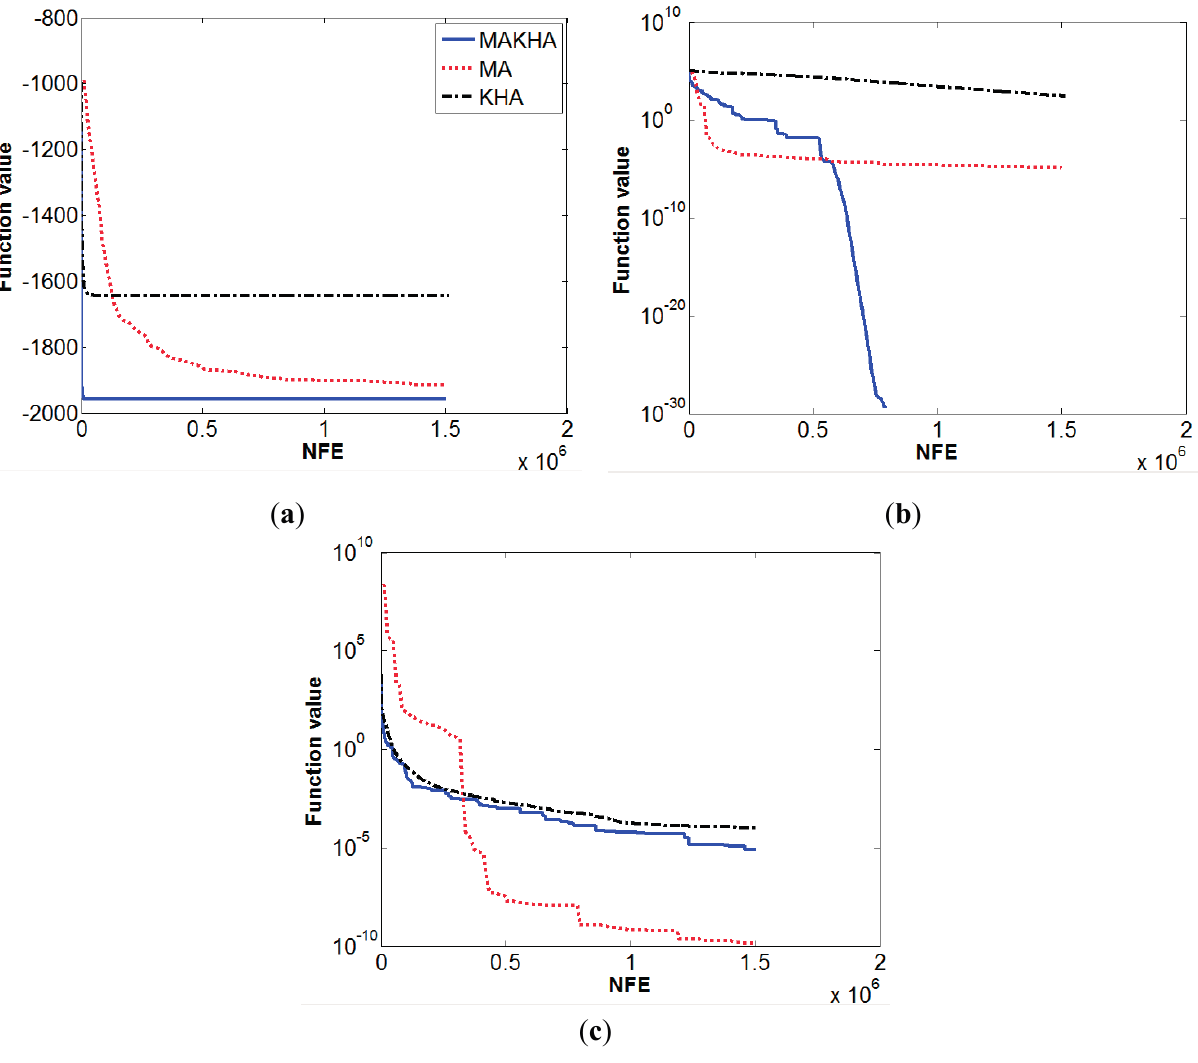
Figure 8. Evolution of mean best values for MA, KHA and MAKHA for: ( a ) Styblinski-Tang, ( b ) Trigonometric and ( c ) Zacharov